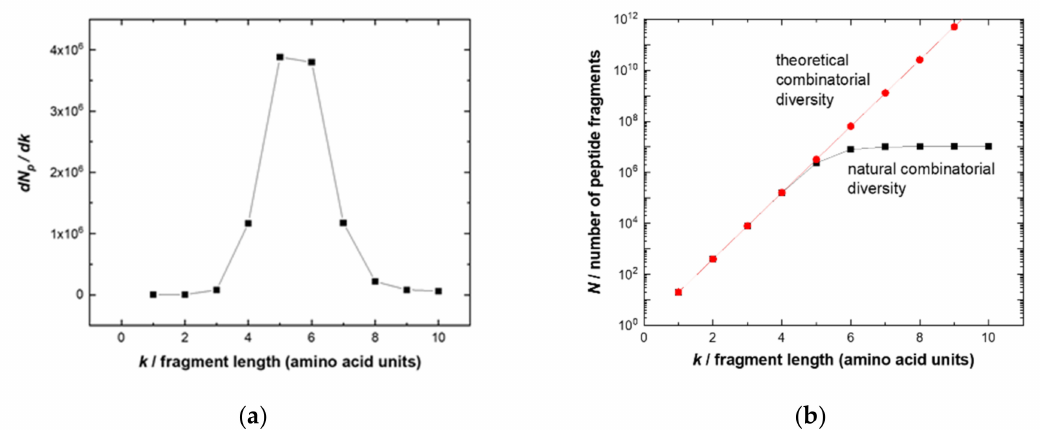
Figure 1. ( a ) Comparison of the number N of unique fragments of the complete combinatorial library (red line with circles) with the number Np of unique fragments of the human peptidome (black line with squares) depending on the length of the peptide fragment. Starting from the 6-mer peptide, Np tends to saturate; ( b ) entropy gain dNp / dk versus the length k of the peptide